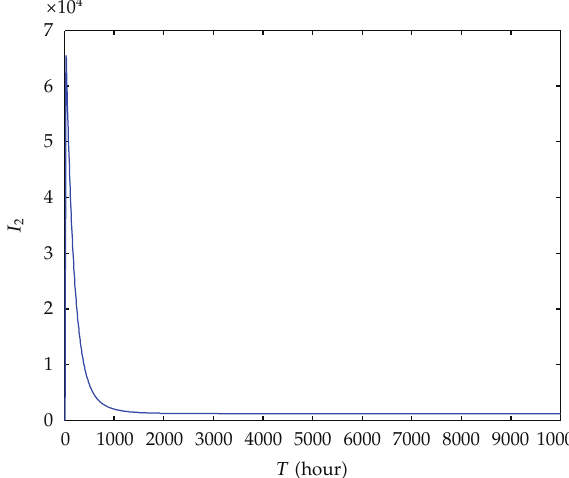
Figure 8: The result of virus propagation when g < g e .